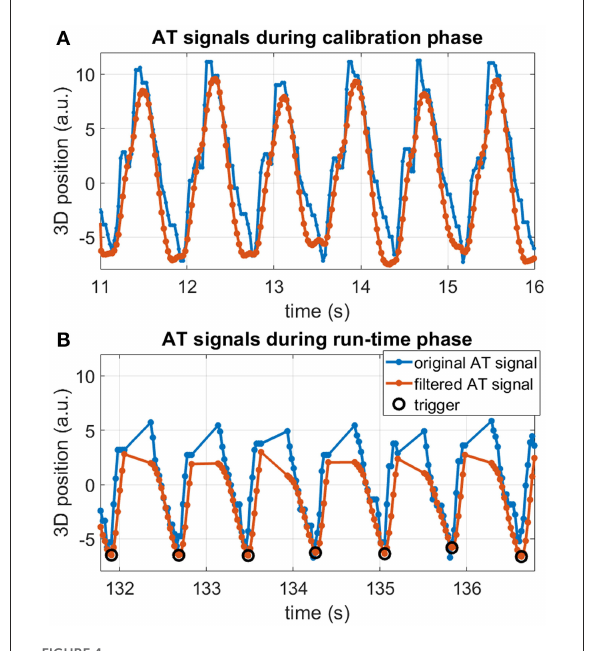
FIGURE4 Example of in vivo AT signal measured in position #5 in the LV for the valley triggering experiment. Original AT signal (blue), filtered AT signal (orange), and detected triggers (black circles). (A) Continuous AT signal acquired during the calibration phase. (B) AT signal segment during the run-time phase, showing triggers and AT signal interruptions by imaging blocks. Regular and consistent valley trigger detection was achieved in all cardiac